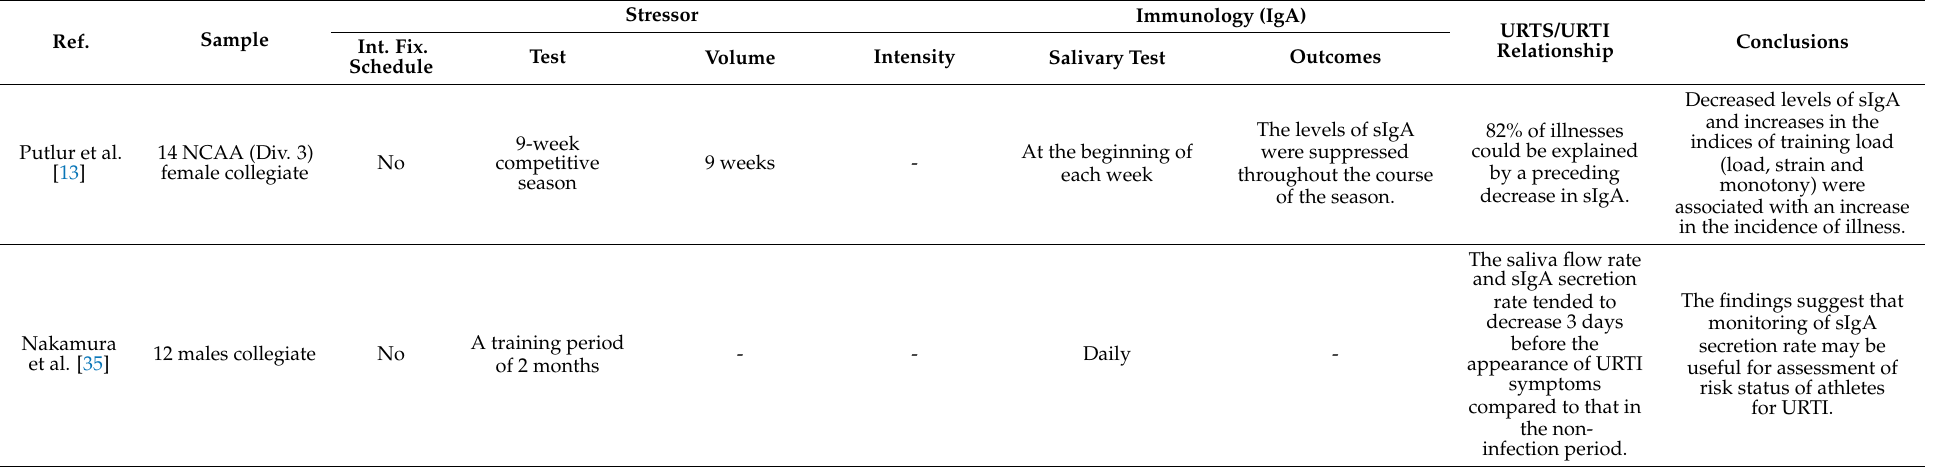
Table 3. Immunoglobulin A responses considering preparation periods (matches/training or training) as a stressor during intensive or non-intensive fixture schedules.